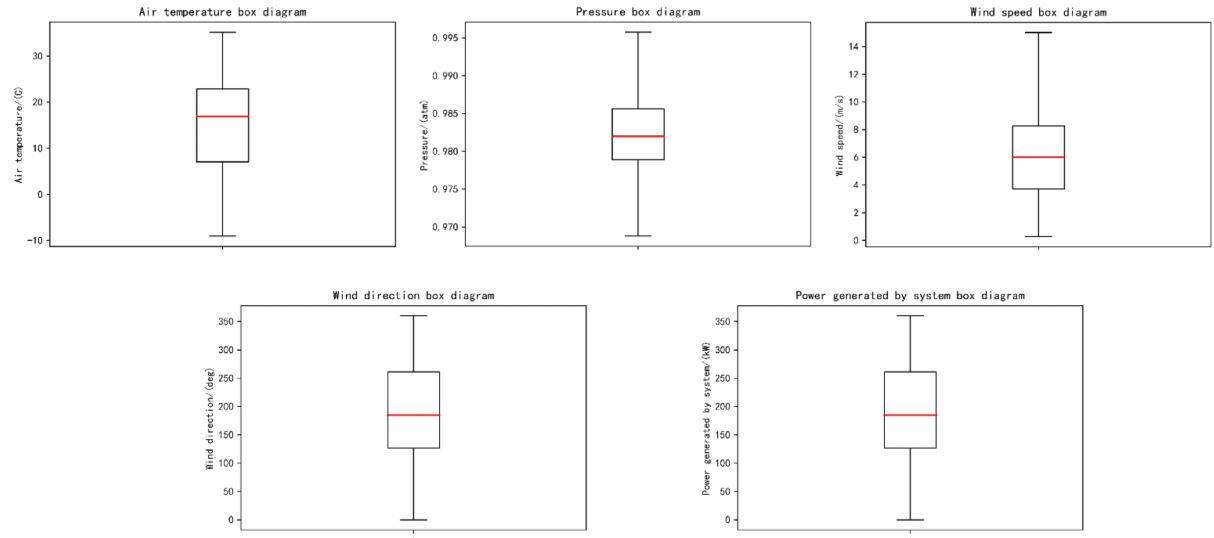
Figure 9. Data box